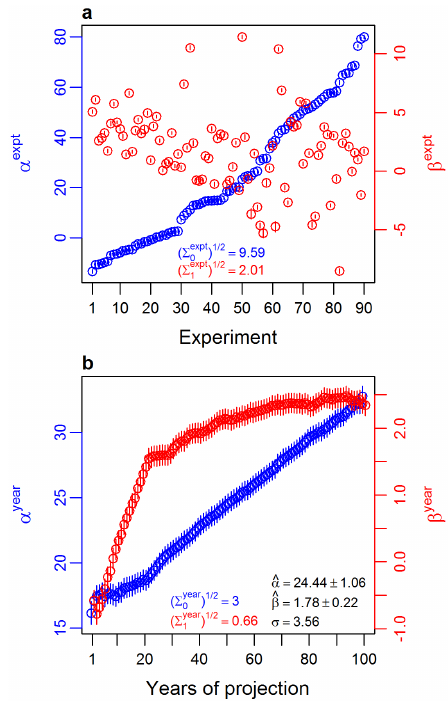
Figure 4. Coefficients (estimate ± SD) for the regression model: U P = α + β C R . The model is fitted to estimate the effects of carbon input (C R ) on the percentage uncertainty ( U P ) in soil organic car- bon projections, applied to 90 experiments (a) and 100 time spans of projection (b) . ˆ α and ˆ β show the data-level coefficients (i.e. av- eraging over experiments (a) and time spans of projection (b) ) and σ represents model error. In (a) , experiments are sorted according to α expt . The coefficients at the experiment × time span level are j not shown. See more details in the “Materials and methods” for the regression